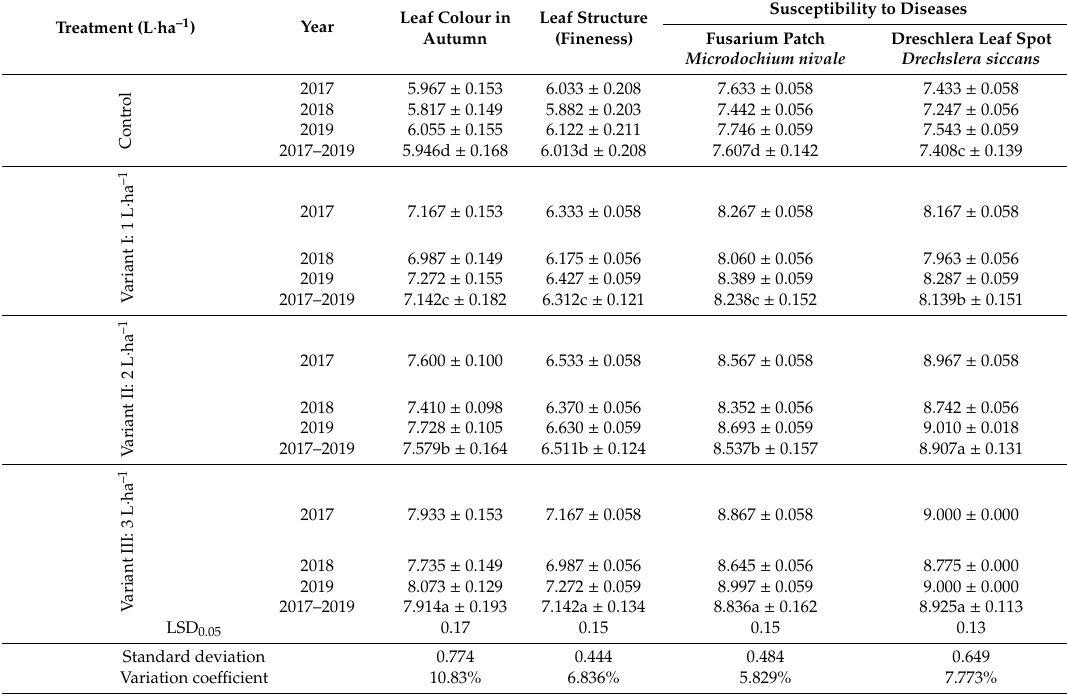
Table 4. Assessment of specific lawn characteristics on a 9-point scale (mean values ± standard